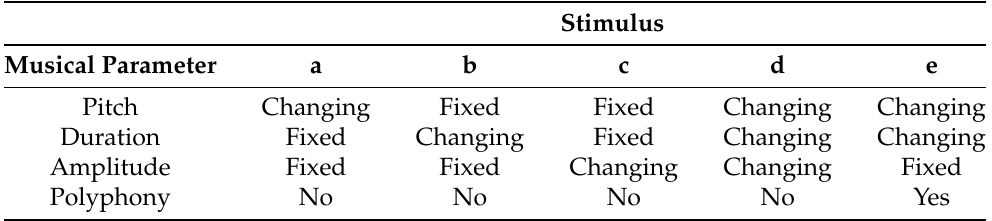
Table 1. Musical stimuli musical parameter